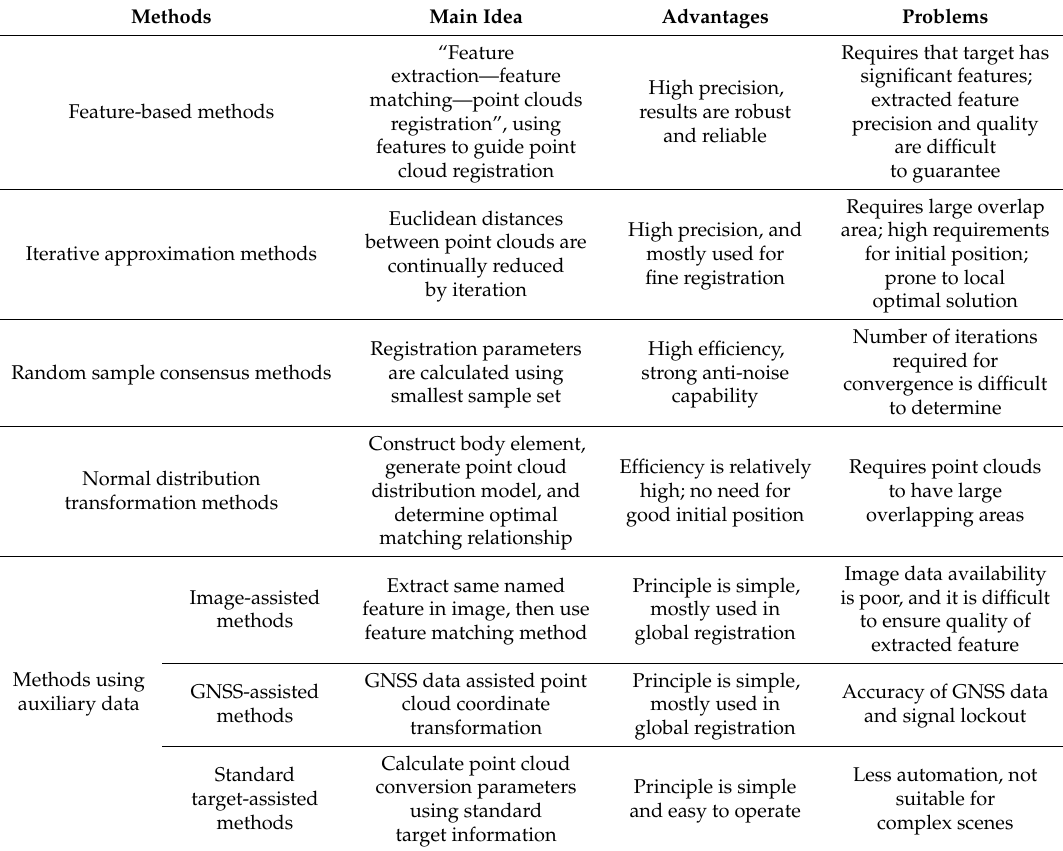
Table 6. Comparison of various point cloud registration